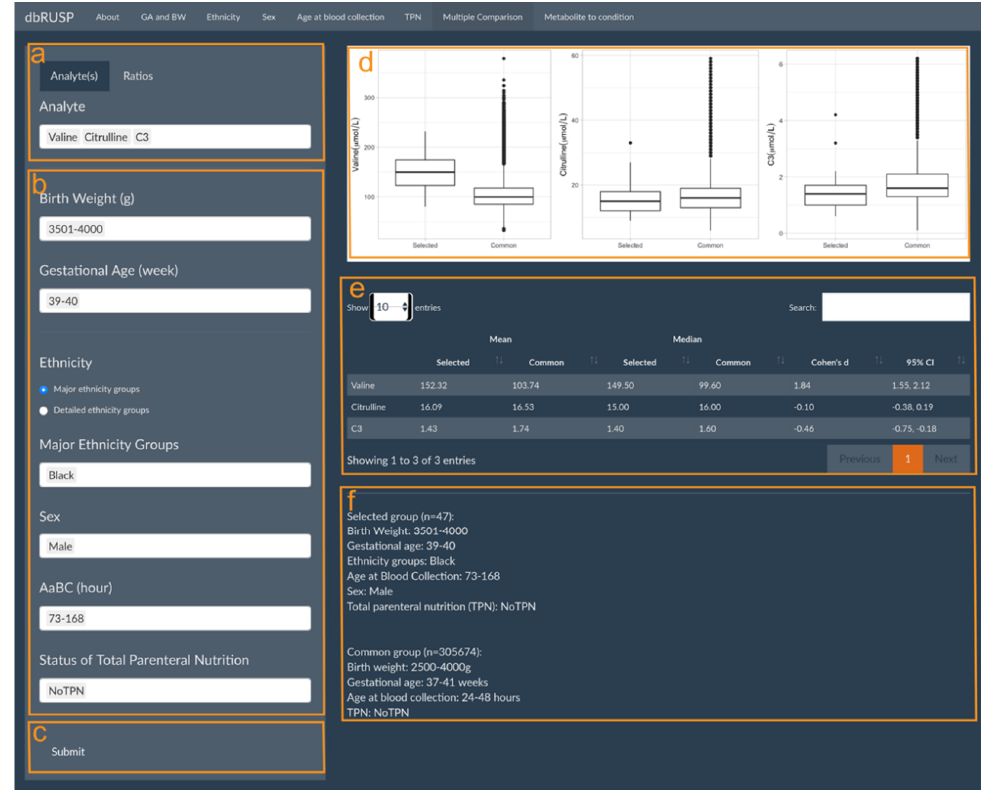
Figure 3. Multiple Comparisons panel under the second module. Panels are provided to select ( a ) metabolic analyte(s) or ratios, ( b ) covariates to choose from in the selected group, and ( c ) submit button to retrieve results. The results panel shows ( d ) parallel boxplots to compare Valine, Citrulline, and C3 levels between the selected and the common reference group, ( e ) a corresponding report of mean and median metabolite values, and ( f ) a description of the selected and common reference groups.